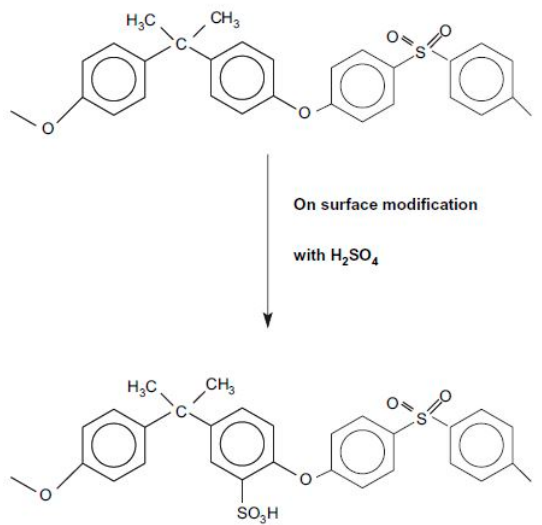
Figure 9. Schematic of the surface modification of PSF through sulphonation [127]. Copyright 2008, reproduced with permission from Elsevier.